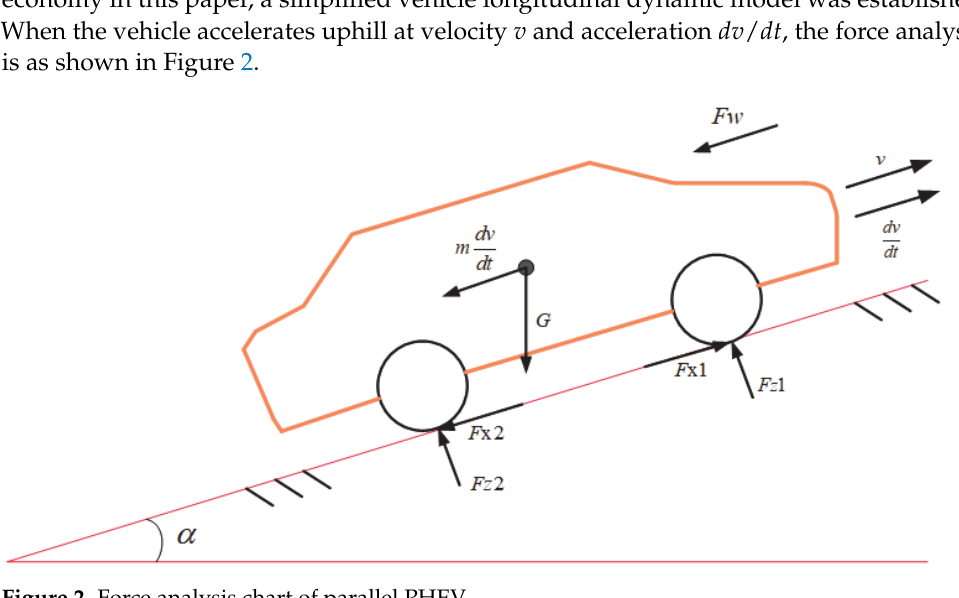
Figure 2. Force analysis chart of parallel PHEV.